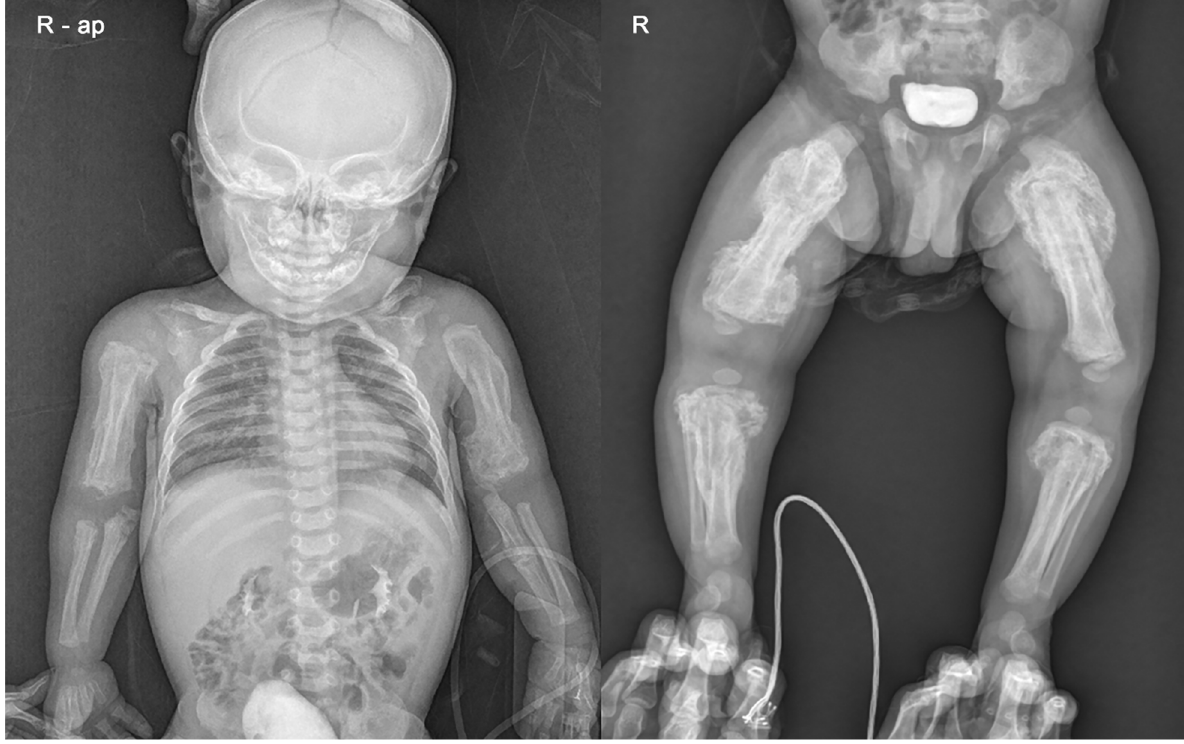
Figure 2. Infantogram and radiograph showing extensive periosteal reaction with multiple fractures in both upper and lower long bones.